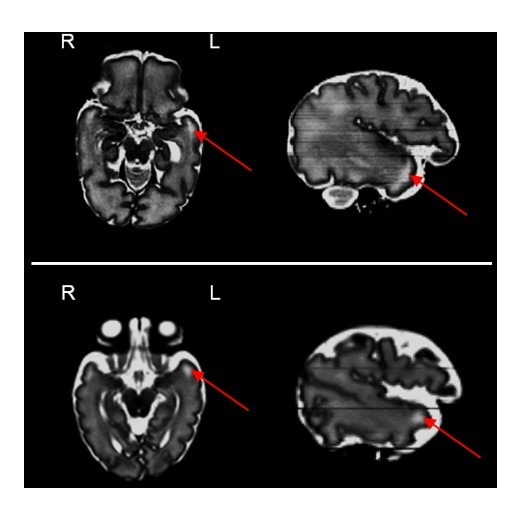
T2-weighted MR images from two infants in our study sample imaged at 32 + 2 weeks PMA (top row) and 35 + 2 weeks PMA (bottom row).As described in the literature, the subplate can be clearly seen as an area of high signal intensity (long T2) on the temporal poles bilaterally (red arrows).